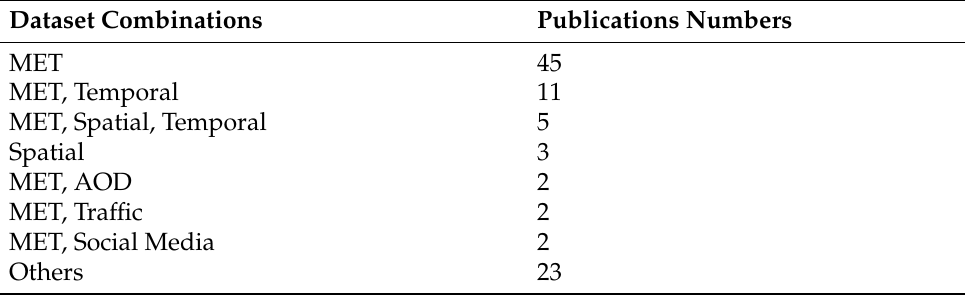
Table 2. The number of publications of dataset